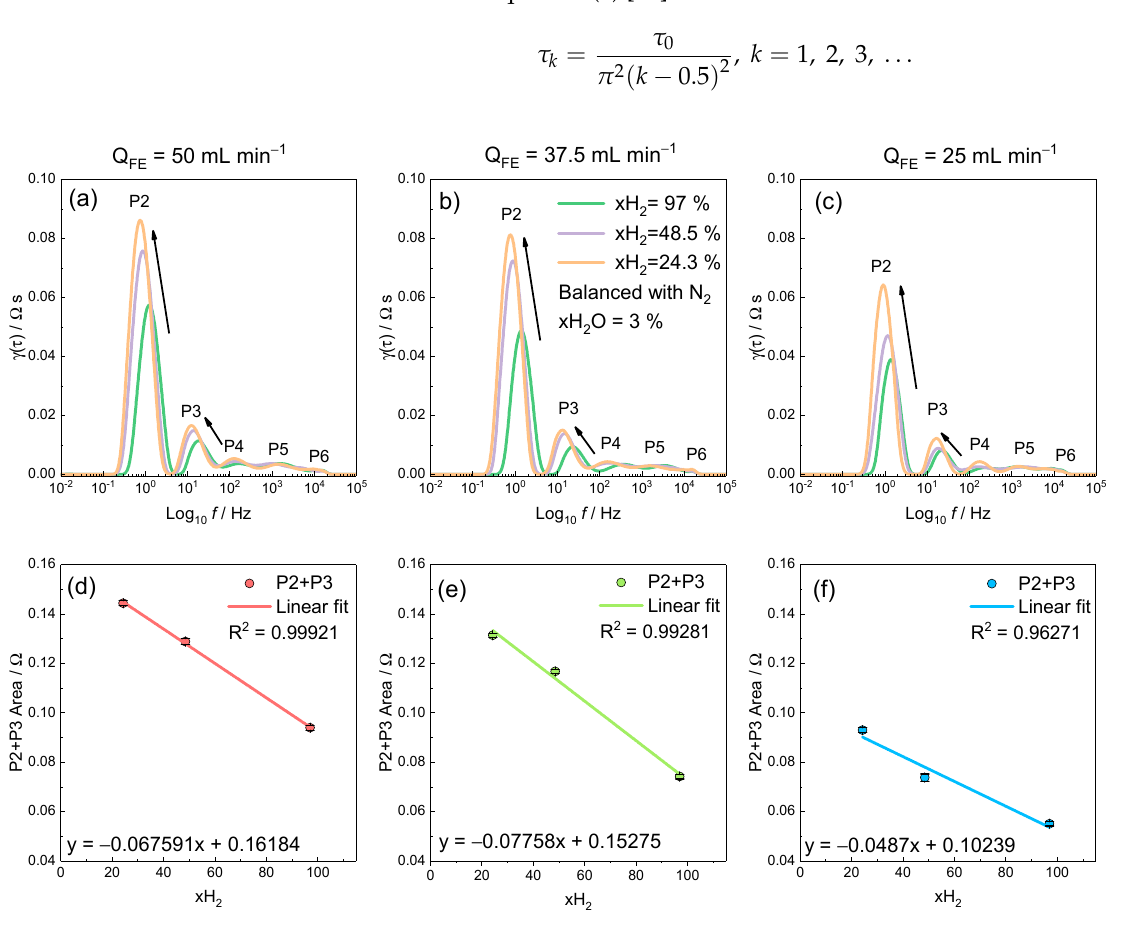
Figure 5. DRT functions of impedance responses obtained at different x H2 and Q FE . ( a ) Q FE = 50 mL min − 1 . ( b ) Q FE = 37.5 mLmin − 1 . ( c ) Q FE = 25 mLmin − 1 . Green line x H2 = 97%, purple line x H2 = 48.5%, and orange line x H2 =24.3%. P2 + P3 peak area vs. x H2 at ( d ) Q FE = 50 mL min − 1 , ( e ) Q FE = 37.5 mL min − 1 , and ( f ) Q FE = 25 mL min − 1 with their respective linear fit. T = 800 °C, AE = air 50 mLmin − 1 (x O2 = 21%), j = OCV.